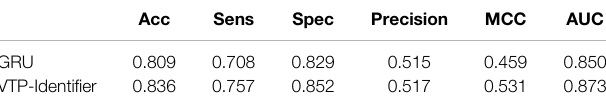
TABLE 5 | Performance comparison between our model and